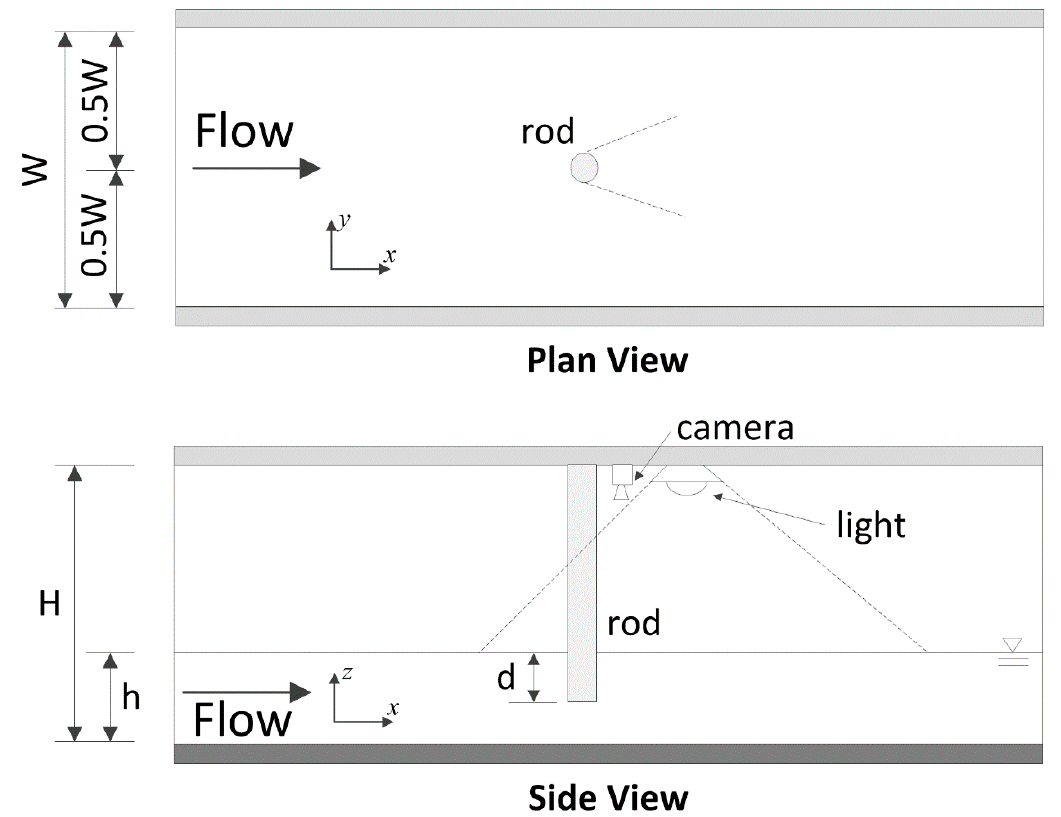
Figure 3. Experimental setup (not to scale). Note: h is the water depth; H is the height from the flume bottom to the ceiling; d is the penetration depth for the rod; W is the flume width.